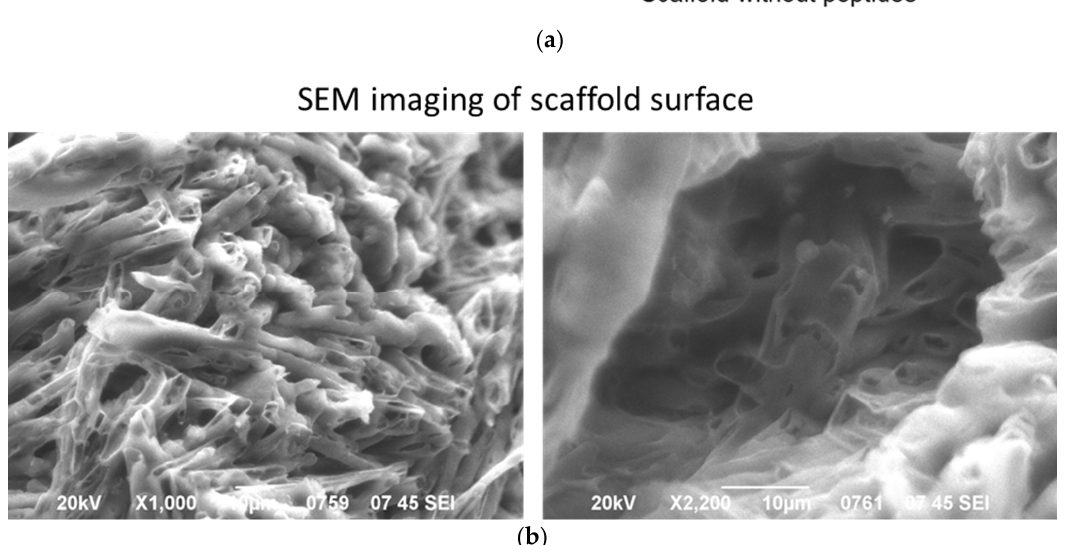
Figure 3. ( a ) Schematic representation of the three-dimensional scaffolds that were produced after the crosslinking reaction. ( b ) Imaging of the micromorphology of the porous surface of the scaffold without peptides by scanning electron microscopy (SEM) at 1000× g (left) and 2200× g (right) magnification. Each photograph has a scale bar of 10 μ m.